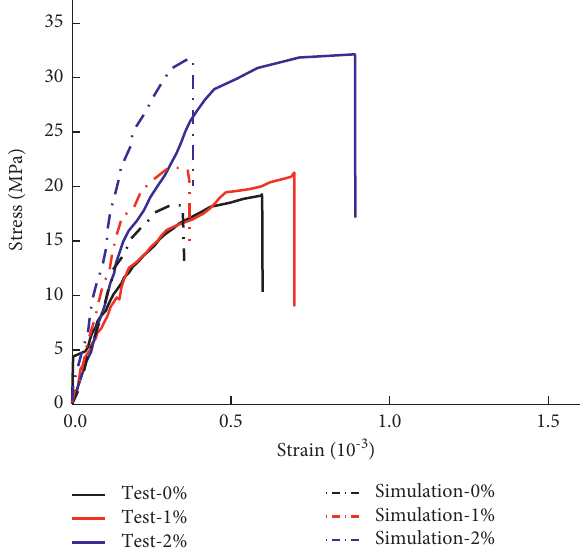
Figure 35: Stress-strain comparison